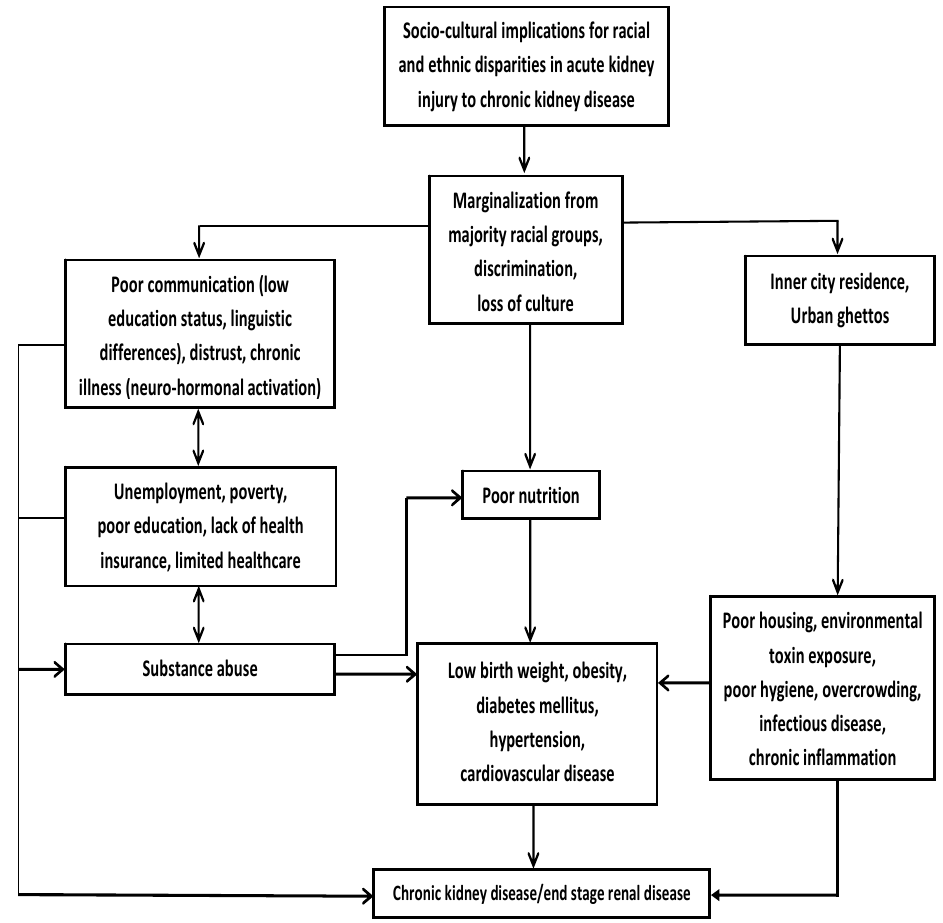
Figure 1. Sociocultural influences on racial/ethnic minority health with implications for progression of acute kidney injury to chronic kidney disease. Adapted with permission from Ref. [6]. 2022, Elsevier.